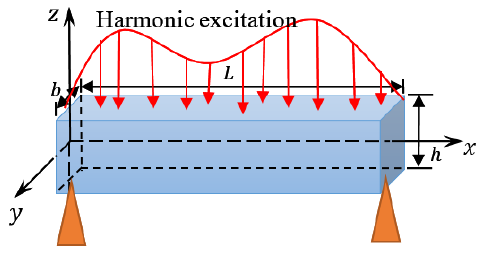
Figure 1. Schematic diagram for the nanobeam.